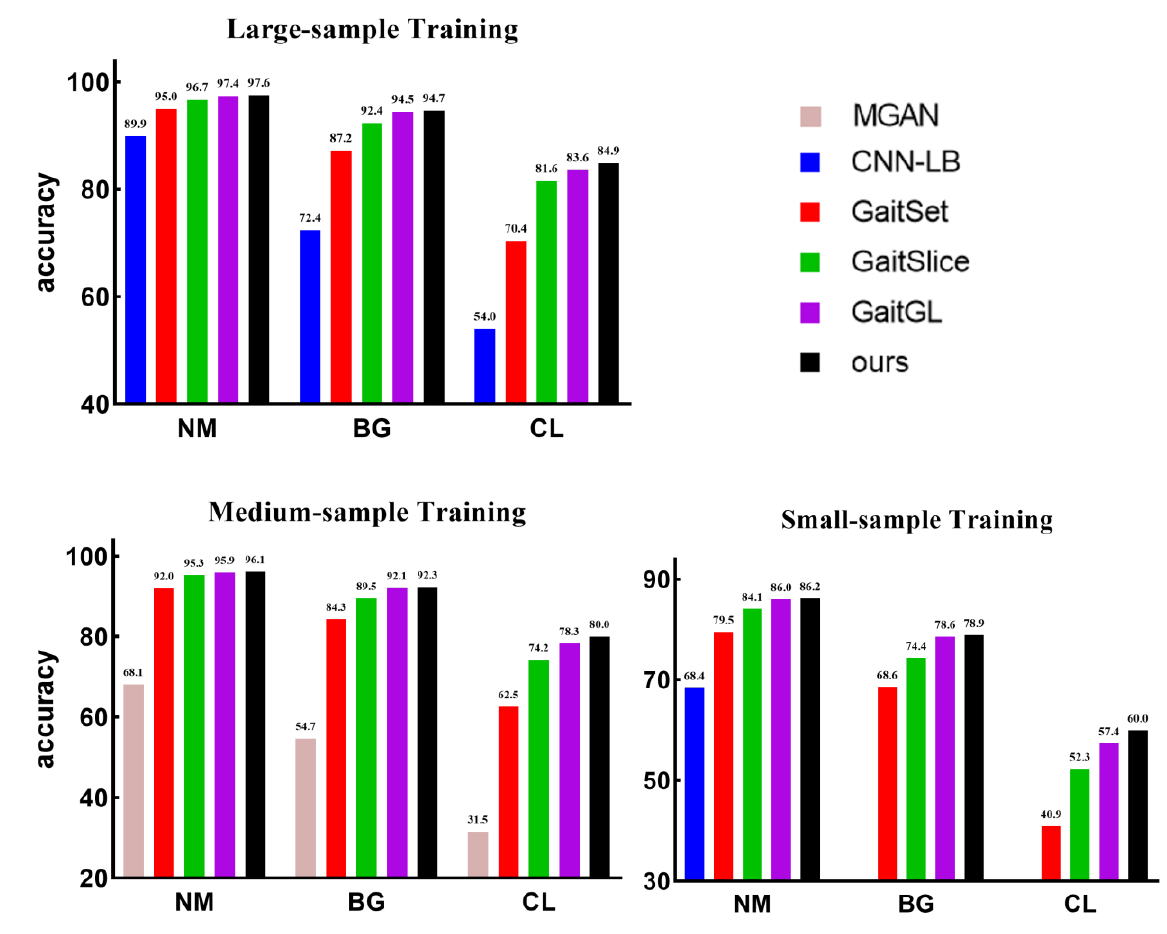
Figure 5. Average rank-1 recognition accuracy of our method compared to other state-of-the-art gait recognition models on CASIA-B under three partition settings.